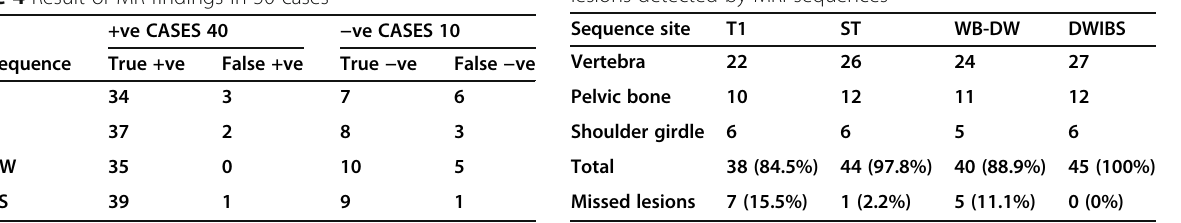
Table 6 Number and site distribution of metastatic